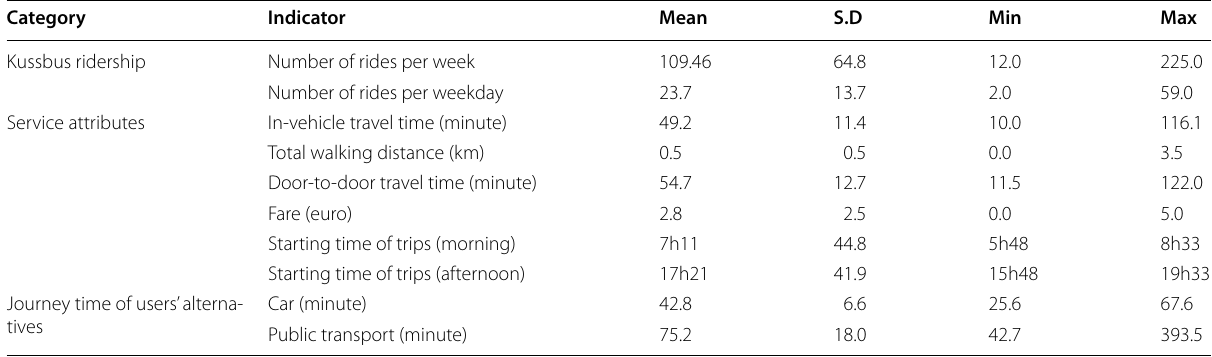
Table 2 Kussbus service attributes and users’ journey time of other transport alternatives